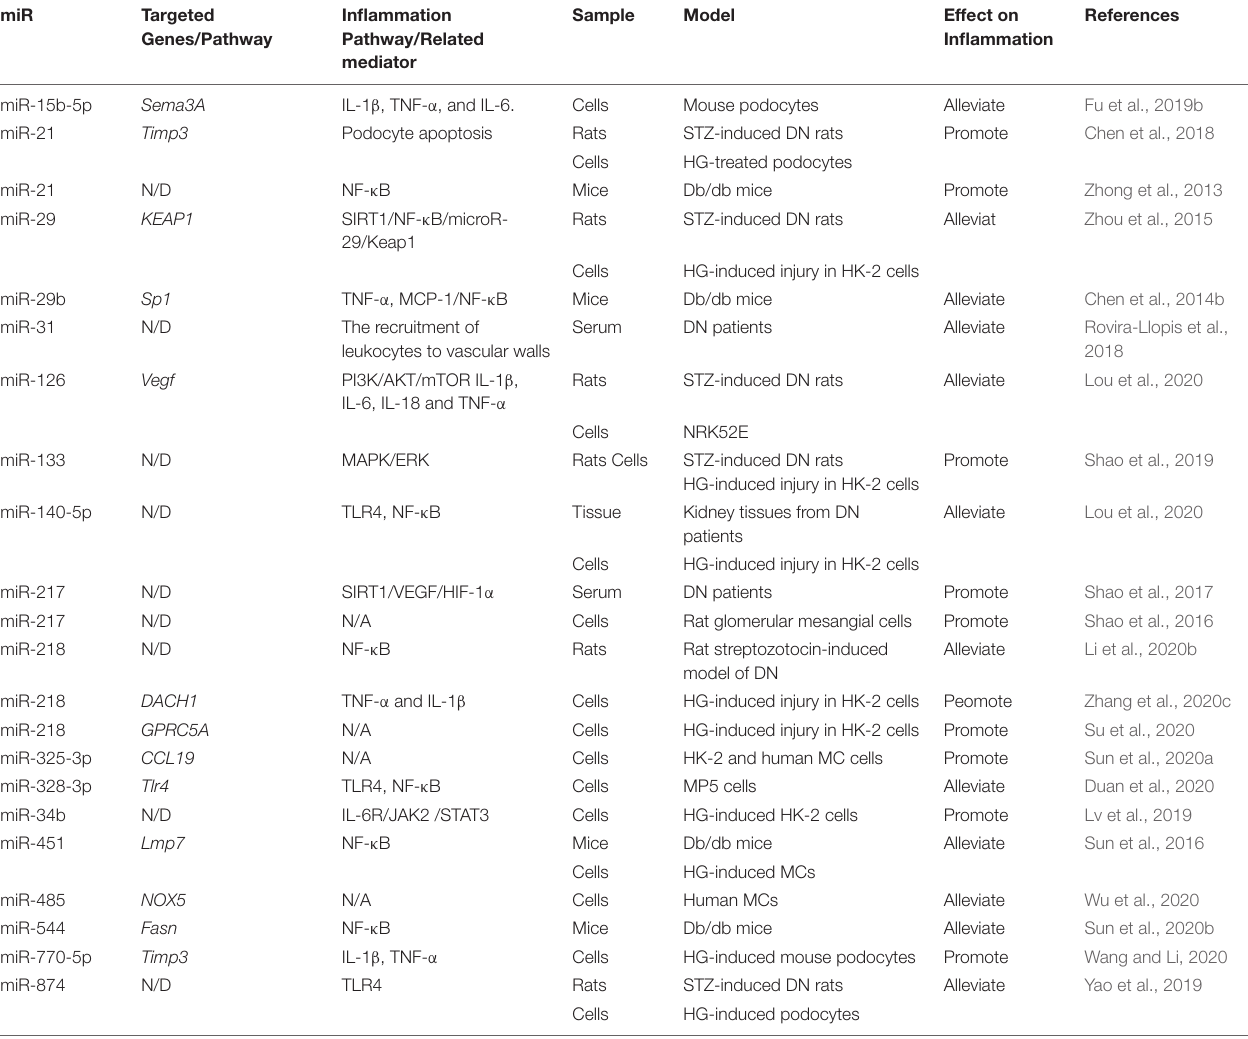
TABLE 1 | The target genes and potential mechanisms of miRNAs associated with inflammation in DN. miR Targeted